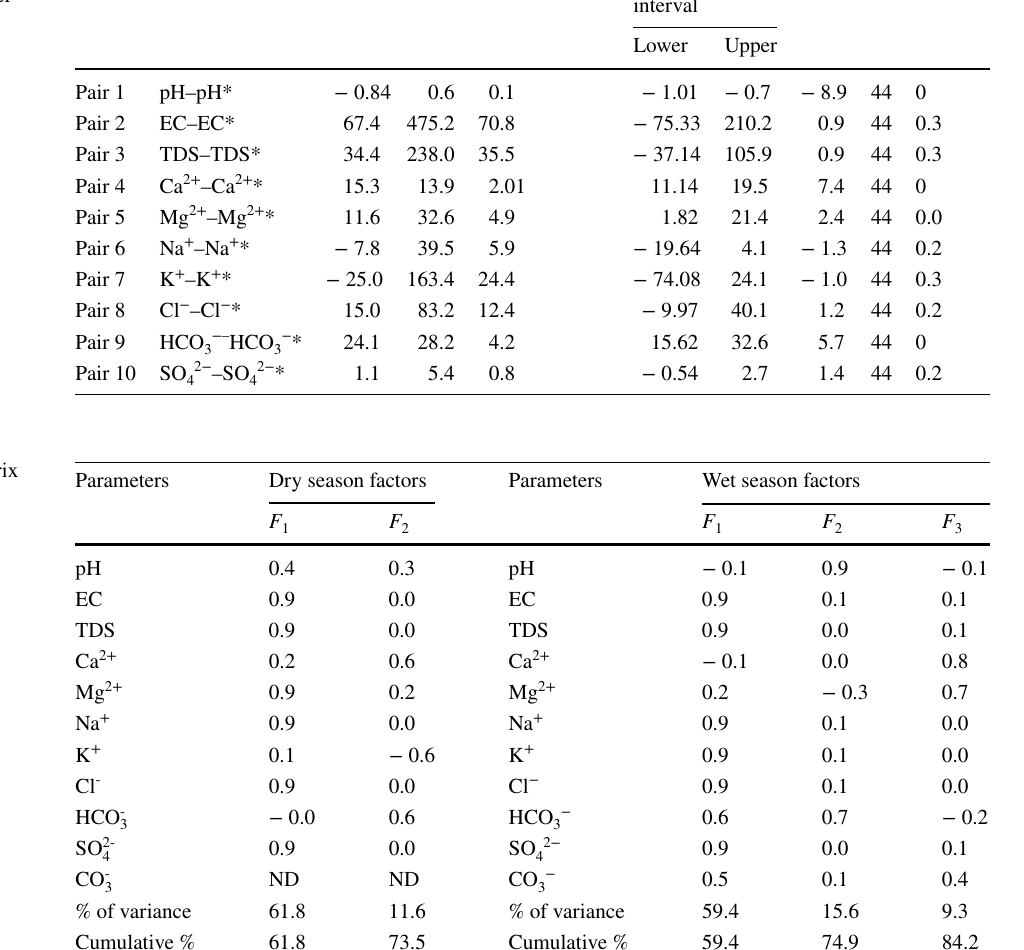
Table 4 Seasonal paired samples T test of groundwater parameters